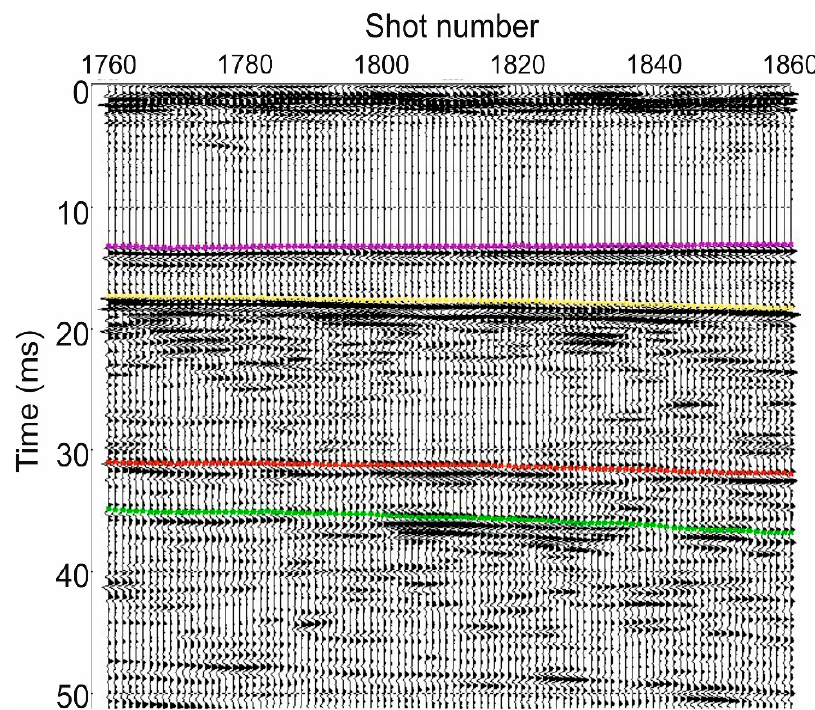
Figure 8. Expanded detail with picked horizons of the central part of Figure 7, from shot point 1760 to 1860: lake floor (violet), base of shallow sediments (yellow), peg-leg multiple (red) and simple multiple (green).